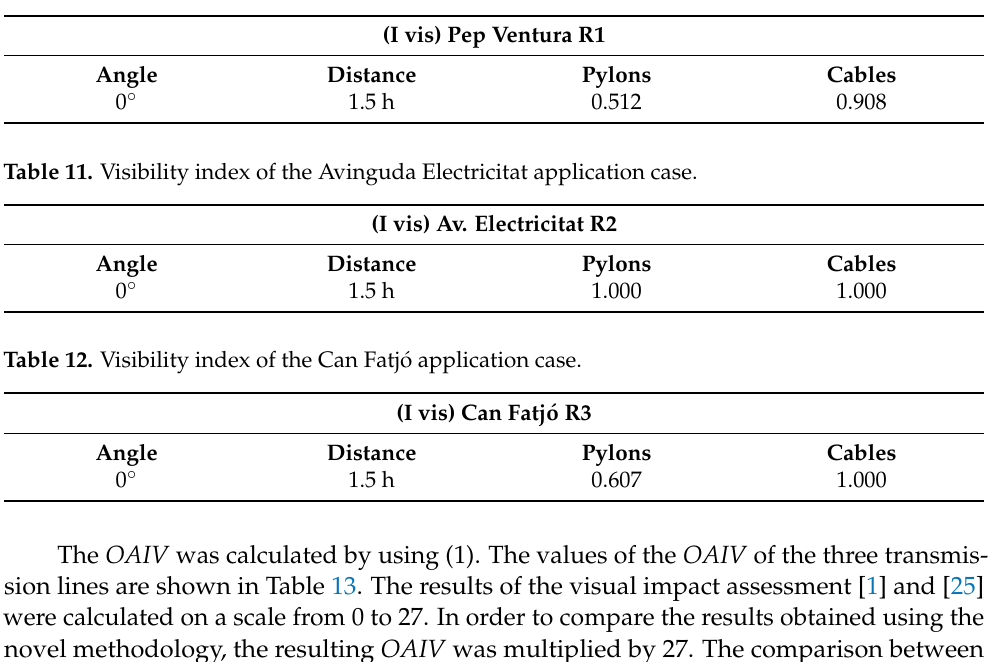
Figure 7. Photograph taken of the 220 kV transmission line Can Jard í -Sant Andreu-Canyet (R2), located at the turnaround Avinguda Electricitat and Passeig de les Torres. Table 10. Visibility index of the Pep Ventura (R1) application case.